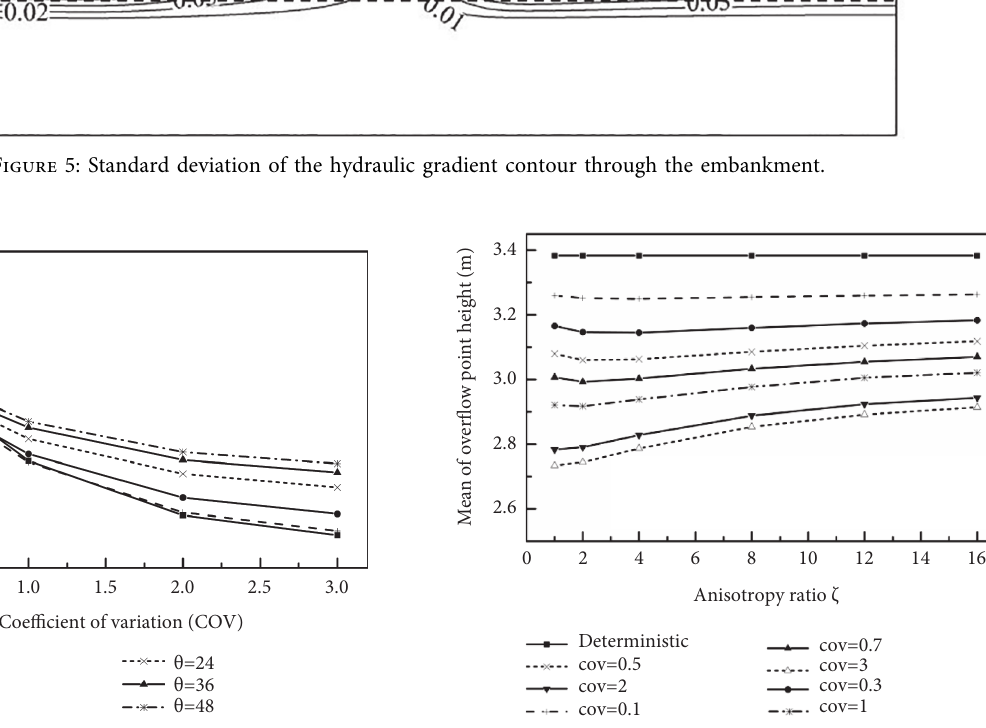
Figure 7: Variation of overflow point height with hydraulic conductivity for different values of ζ